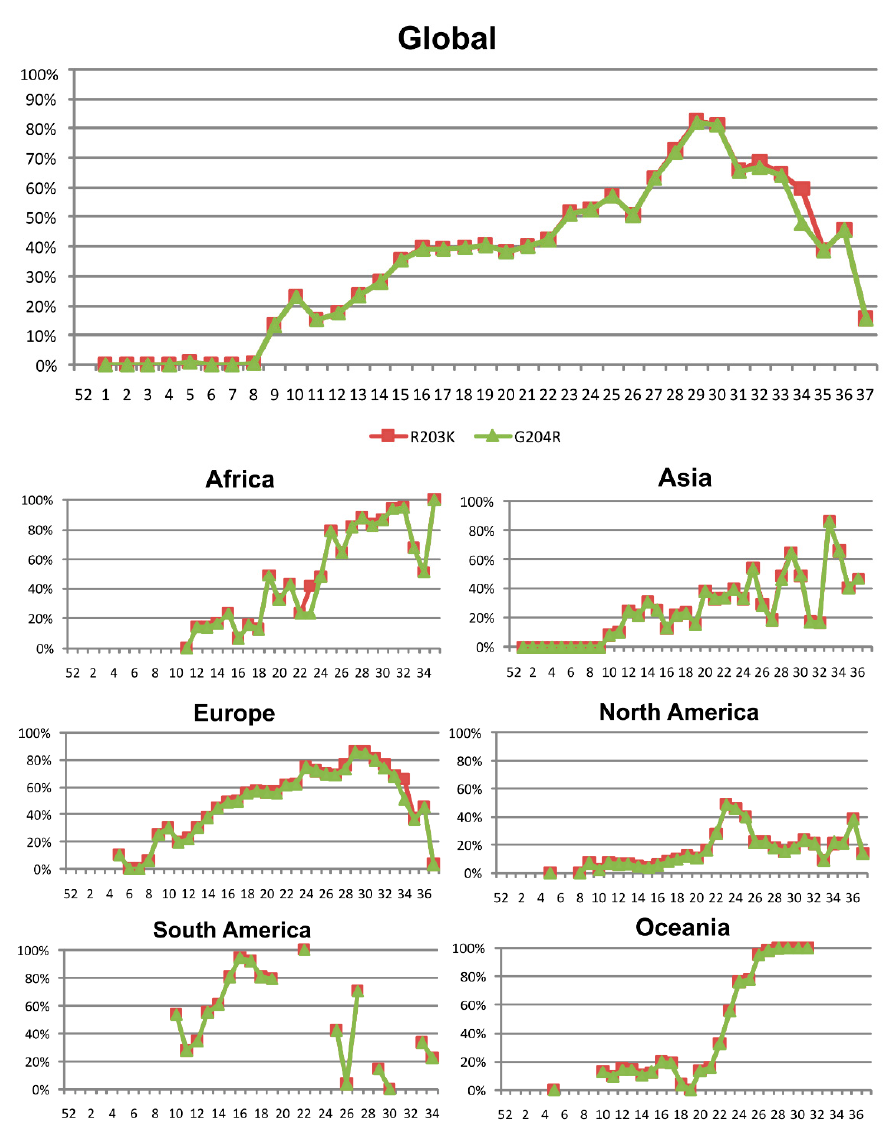
Figure 3. Global and regional frequency of the R203K and G204R combination in the nucleocapsid SARS-CoV-2 protein over time. The figure only includes data of those epiweeks with at least 10 nucleocapsid sequences. The x -axis represents epidemiological week and the y -axis represents percentage of mutated sequences. Color code, red (R203K) and green (G204R). R, arginine; K, lysine; G, glycine.